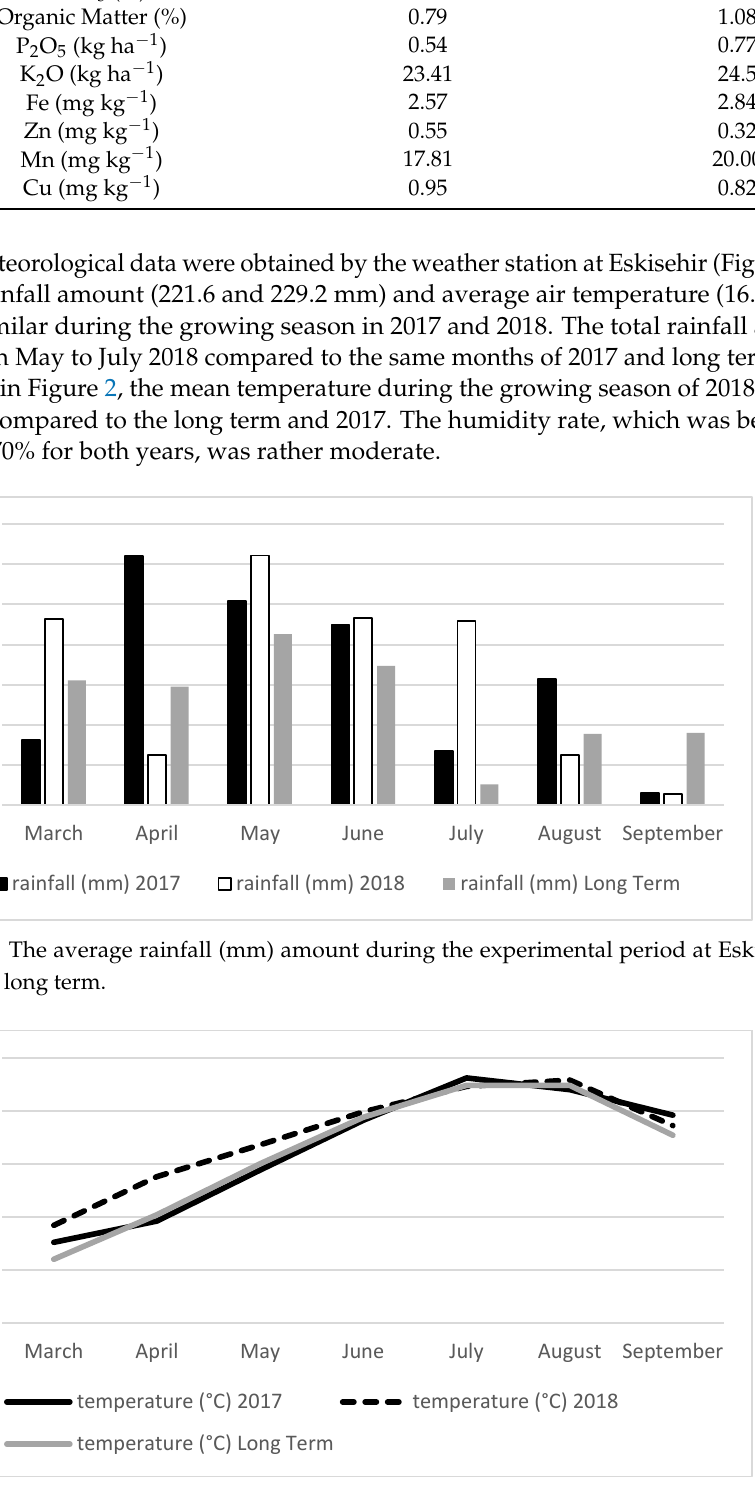
Figure 2. The average air temperature ( ° C) during the experimental period at Eskisehir in 2017, 2018 and long term.